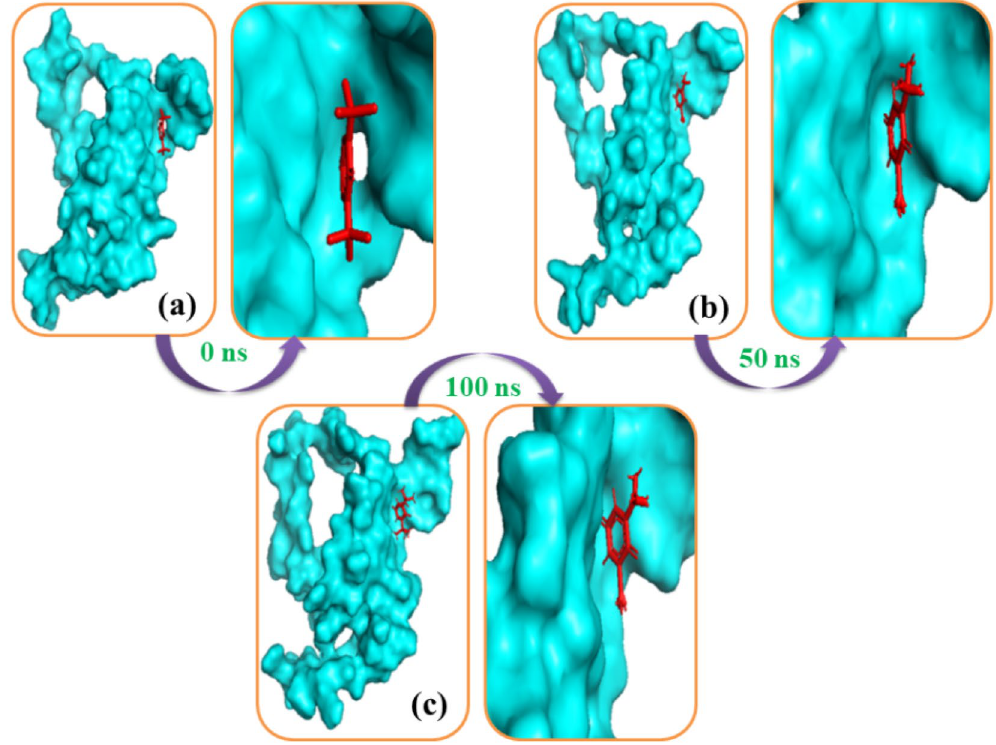
Figure 11. The simulation snapshots of MYB gene and 2,6-ditert-butylcyclohexa-2,5-diene-1,4-dione complexes acquired from the trajectories, where rigid profiles of the ligand–protein complex were observed in the same binding pockets. The snapshots ( a – c ) were taken after 0, 50, and 100 ns intervals,